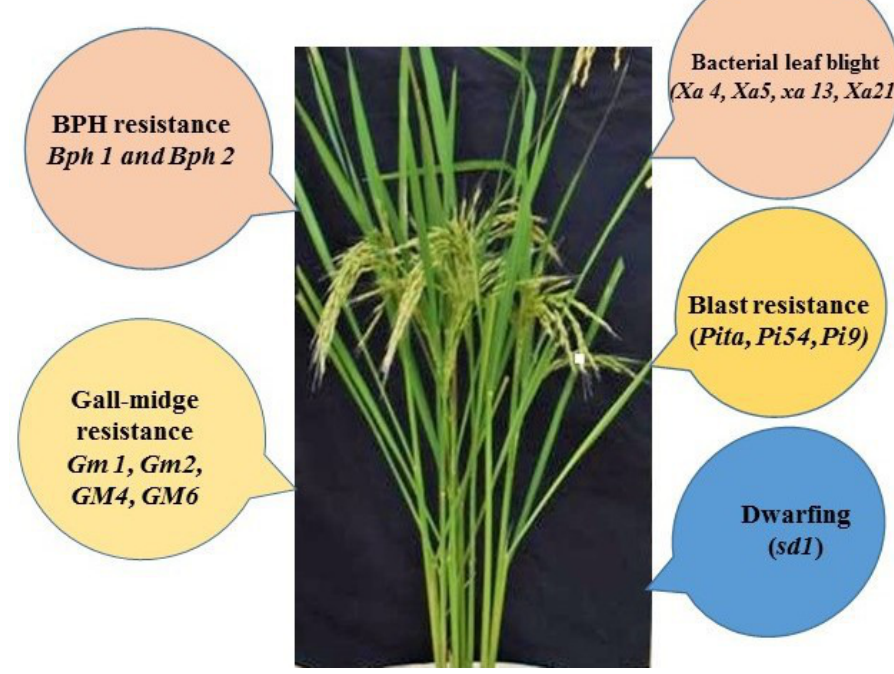
Figure 5. Pyramiding of desired genes in a cultivar using functional markers (FMs).